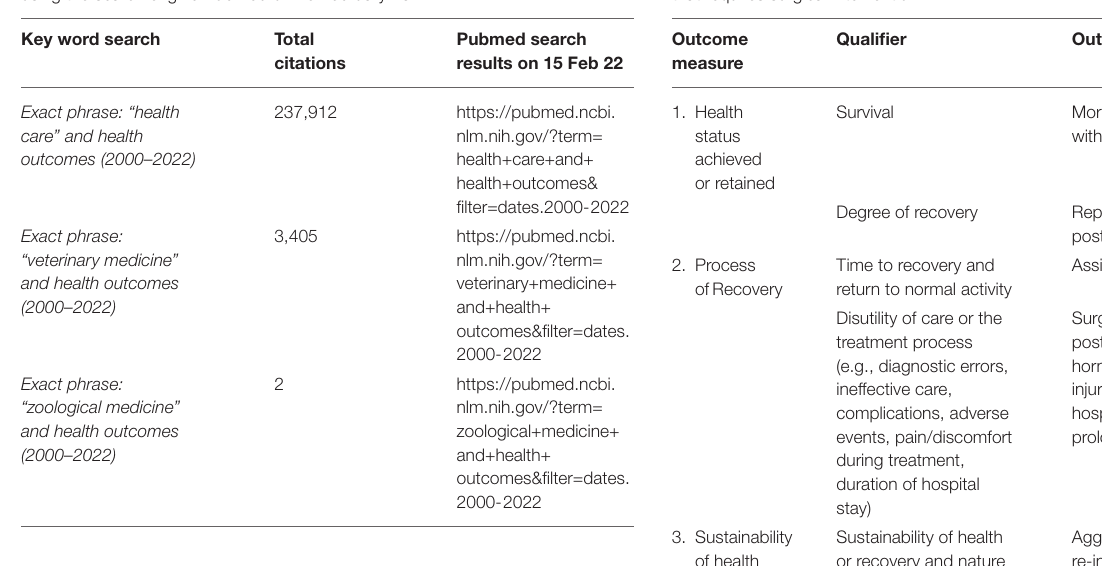
TABLE 2 | Outcomes measures hierarchy using a case of dystocia in an antelope that requires surgical